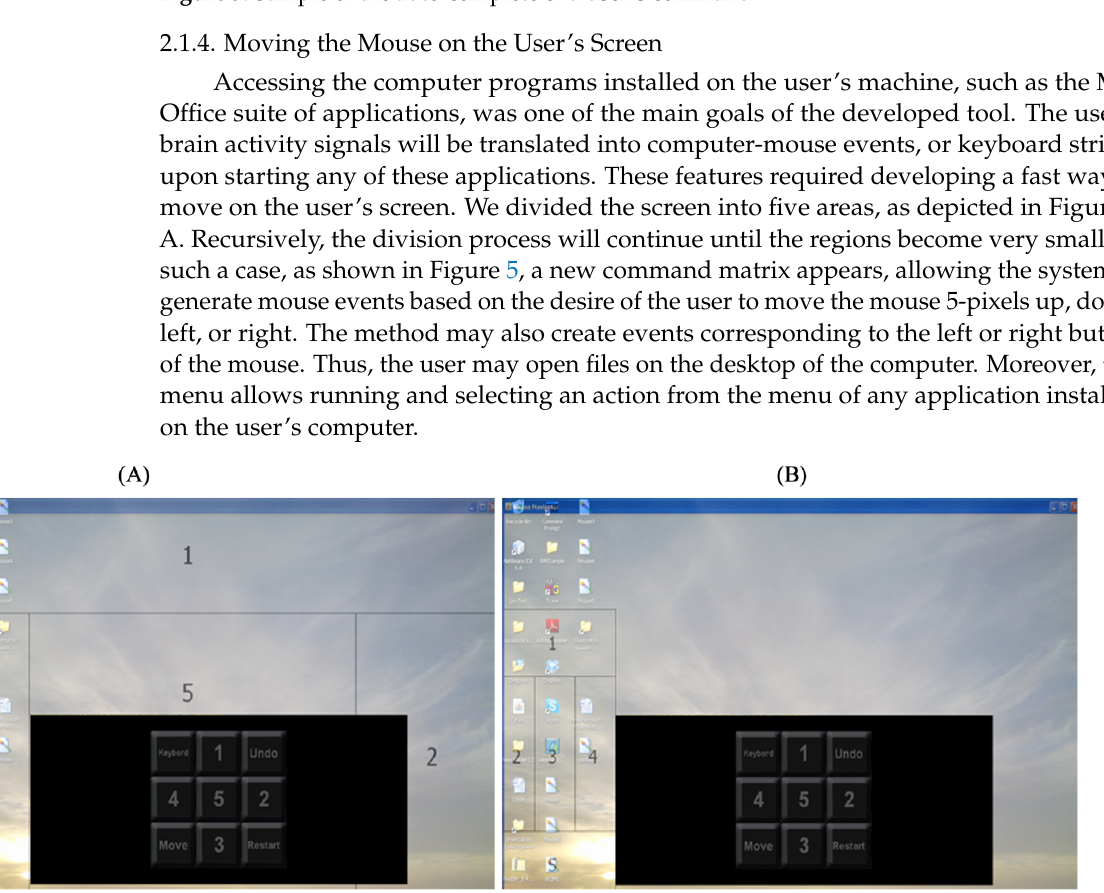
Figure 3. Sample of the auto-complete of a user’s command.